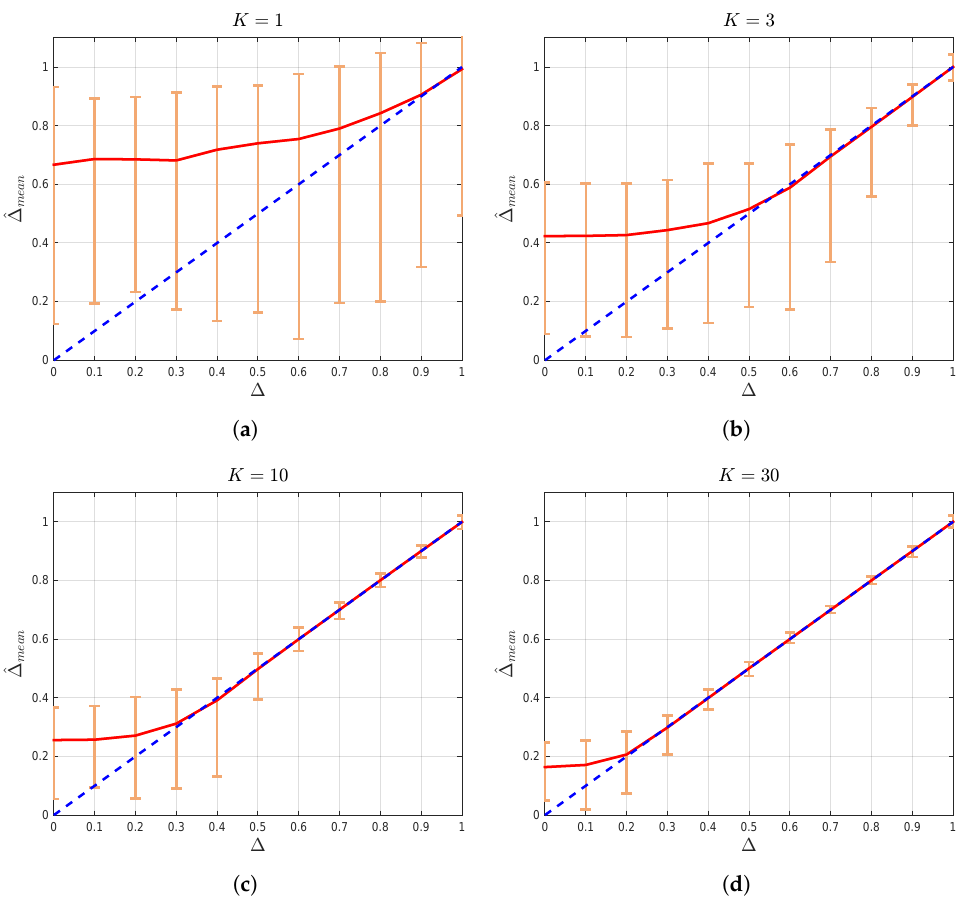
Figure 1. ˆ ∆ mean (with absolute error bars) vs. ∆ for ( a ) K = 1, ( b ) K = 3, ( c ) K = 10, and ( d ) K = 30. The solid line shows a linear regression fit to the data. The unit slope dashed line is illustrated as a